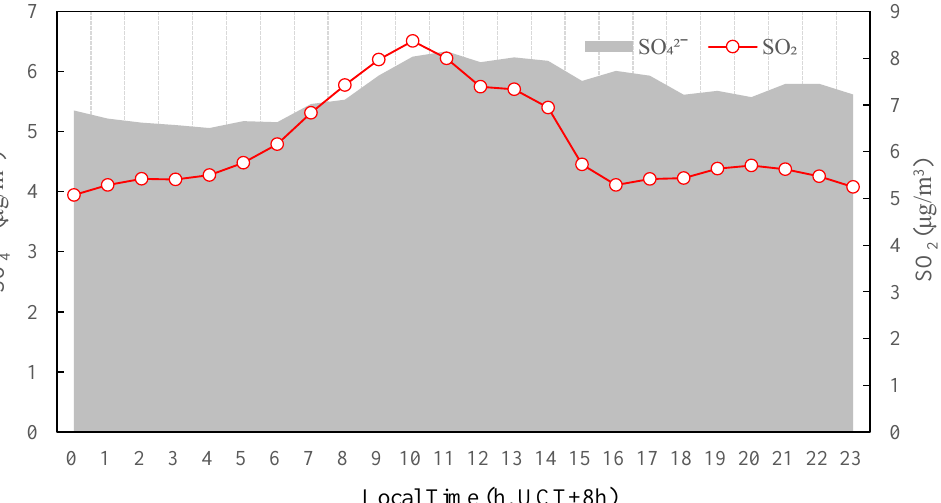
Figure 11. Diurnal variation in SO 4 2 − and SO 2 concentrations averaged under the photochemical activity levels M, LH, and H in the summertime 2020 in Tianjin, China.